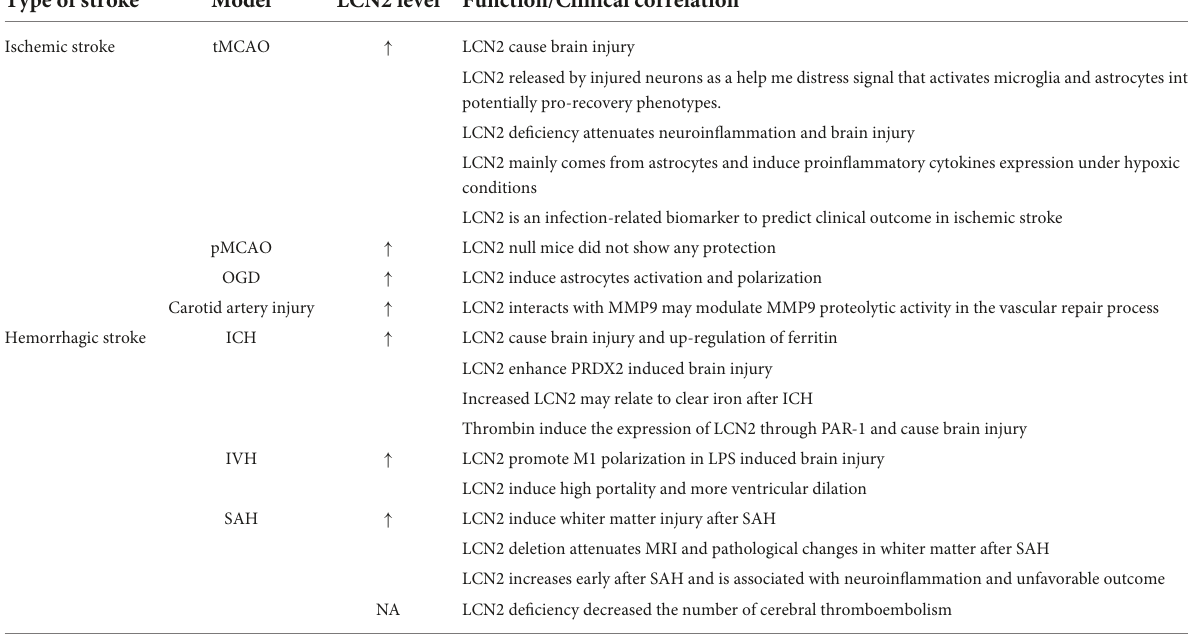
TABLE 2 Expression of LCN2 in the plasma and brain of stroke patients and stroke-induced animal models. Type of stroke Model LCN2 level Function/Clinical correlation Ischemic stroke